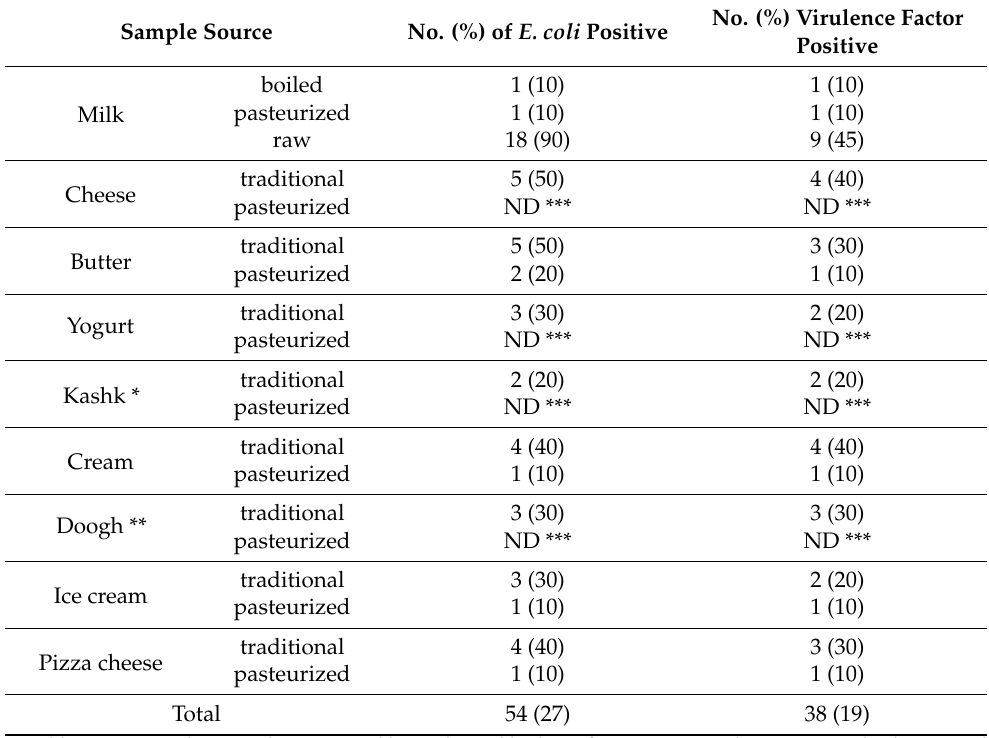
Table 1. The prevalence of E. coli and its virulence factors isolated from milk and dairy products. Sample